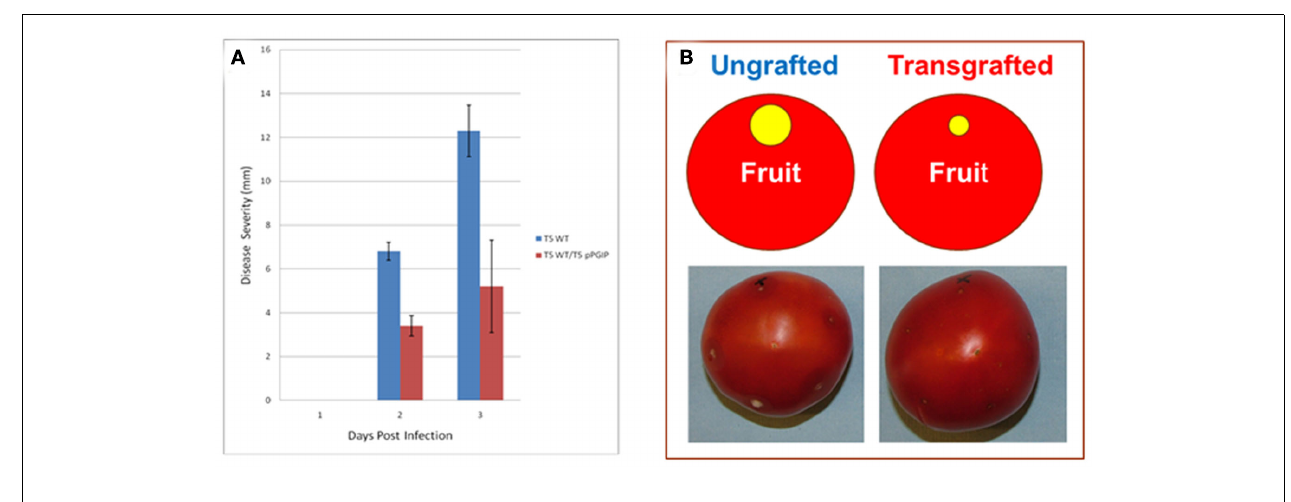
puncture sites with 1000 B. cinerea spores in 10 μ l water. Fruit were maintained in moist crispers at 20˚C and lesion diameter was measured daily (Cantu et al., 2008a, 2009). SE of the mean (SEM) are indicated. (B) Image of infected fruit 3days post